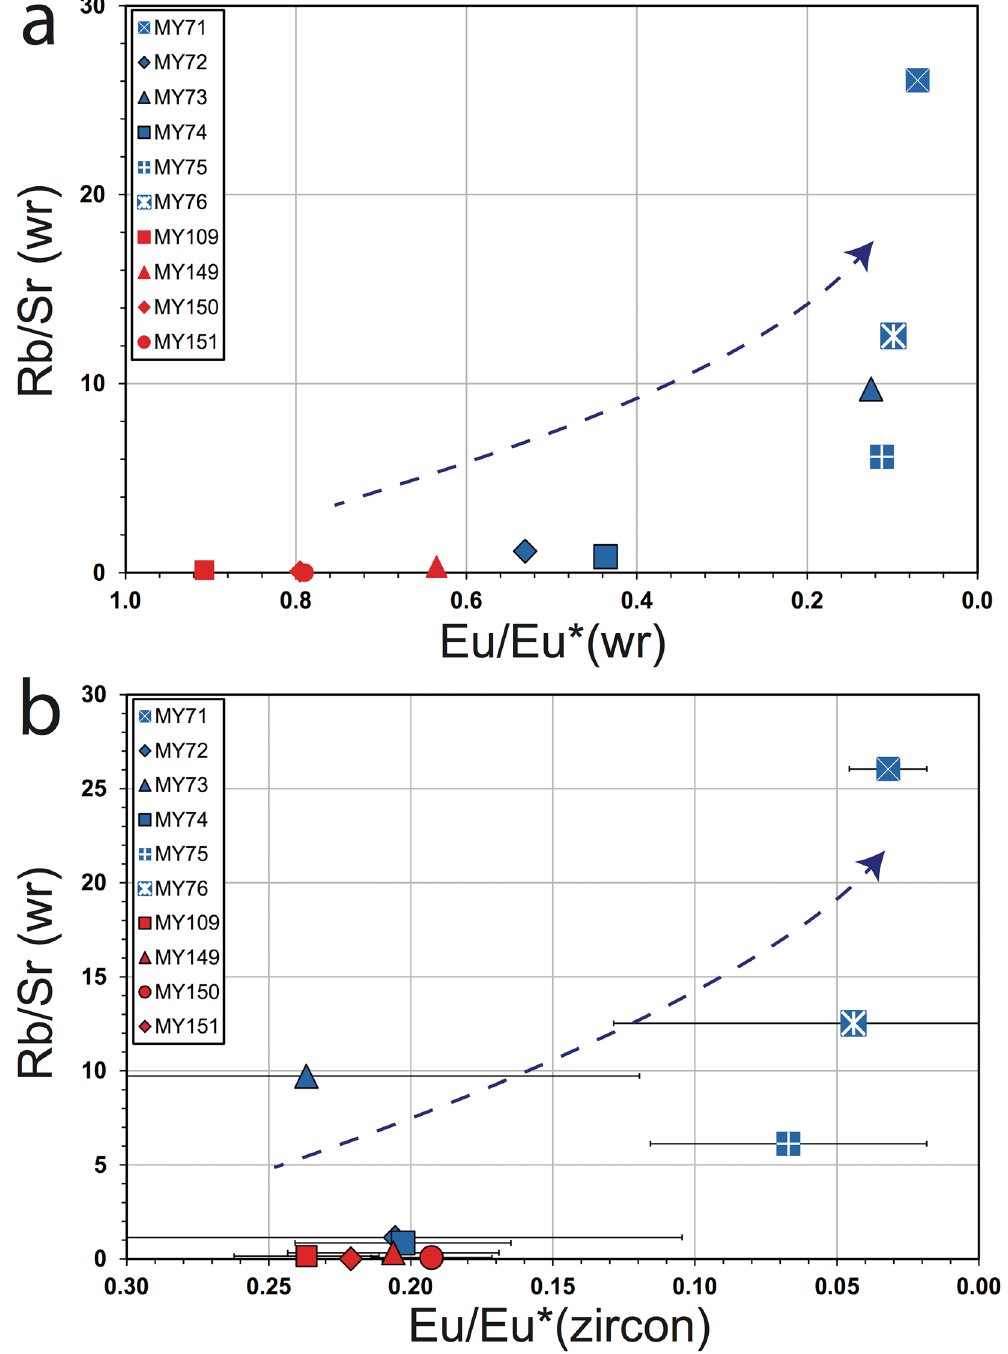
Figure 3. Whole-rock and zircon trace element plots highlighting the relationship between Rb/Sr and Eu/ Eu * , plotted by sample and suite. Samples MY71, MY75 and MY76 have a high ( > 15 ppm) Sn content (white crosses). ( a ) Whole rock Rb/Sr plotted against whole rock Eu/Eu * , and a relationship between these is observed, indicating that Eu/Eu * is sensitive to the degree of magma fractionation. ( b ) Sn belt and Cu arc whole rock Rb/ Sr plotted against median zircon Eu/Eu * , showing a relationship that reflects the degree of fractionation of the individual samples. Error bars are 1 σ . The zircon Eu/Eu * values are less (i.e. the size of the Eu anomalies are greater) than those in the corresponding whole